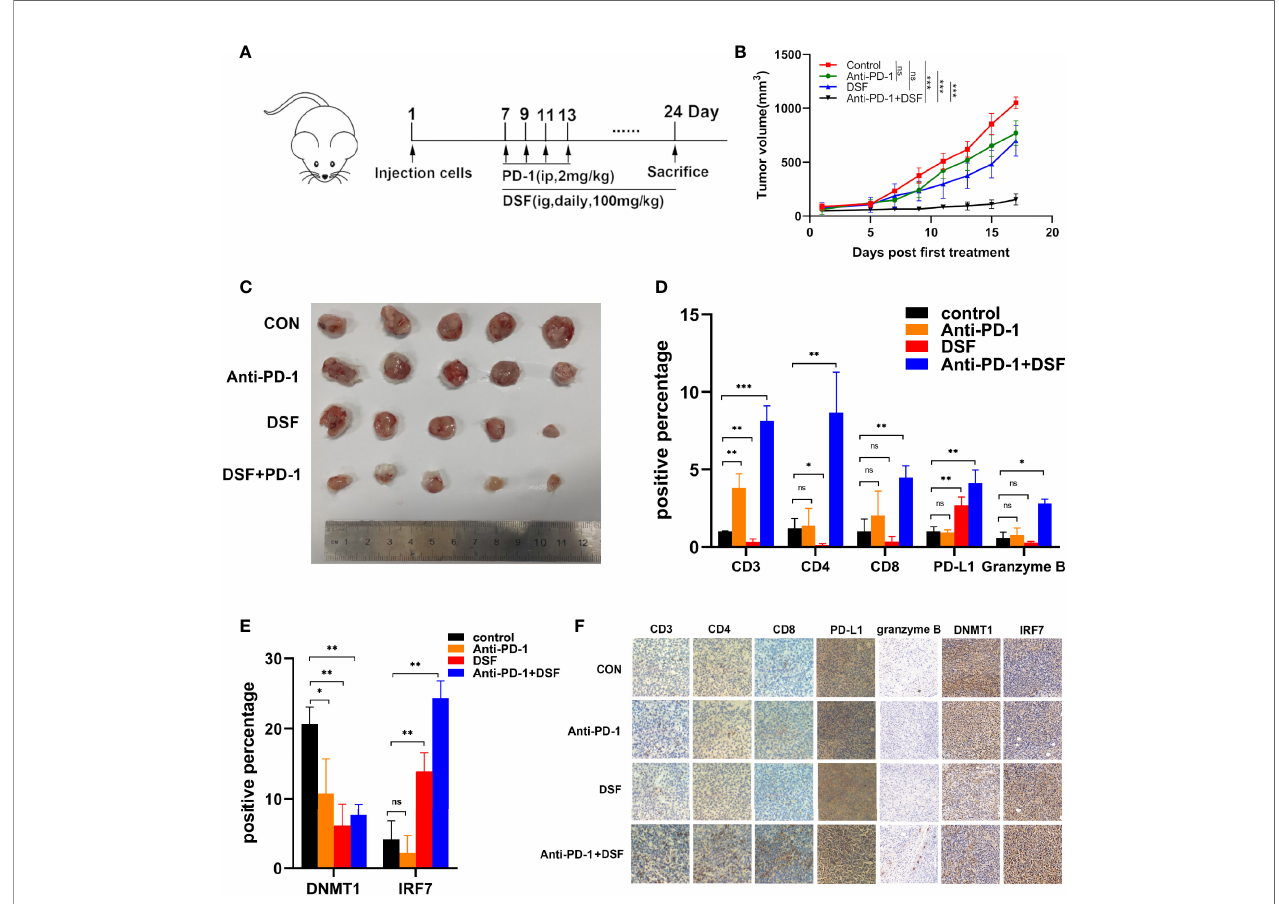
FIGURE 5 | Thecombinationofanti-PD-1therapywithDSFimprovesantitumoractivity. (A) BALB/cmicewereinoculateds.c.with4T1cells.Sevendaysafterinoculation, mice begantoreceiveDSF(i.g., daily, 100mg/kg),anti-PD-1blockingantibodies (i.p.,fourtimes, 2mg/kg), acombinationofreagentsor solventcontrolasindicated. (B) Representative photographsof4T1tumorofthemiceaftertreatmentwithDSFand/oranti-PD-1blockingantibody. (C) 4T1implantedtumor-bearingmicewererandomlyenrolledindifferent treatmentgroupsasindicated.Foreachtreatmentgroup,tumorvolumesweremeasuredevery3daysandplottedindividually. (D) ThepositivepercentageofCD3,CD4,CD8, PD-L1,andgranzymeBin4T1tumors. (E) ThepositivepercentageofDNMT1andIRF7in4T1tumors. (F) Immunohistochemicalstainingfor CD3,CD4, CD8,PD-L1,granzyme B,DNMT1,andIRF7in4T1tumors.*p<0.05,**p< 0.01,***p<0.001.ns,nostatisticsigni fi